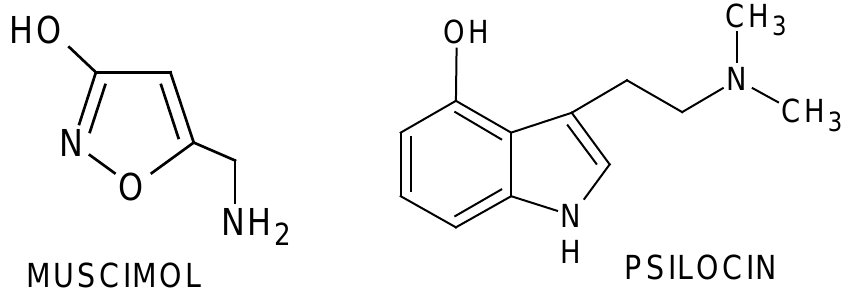
Figure 5. Chemical structures of muscimol and psilocin.